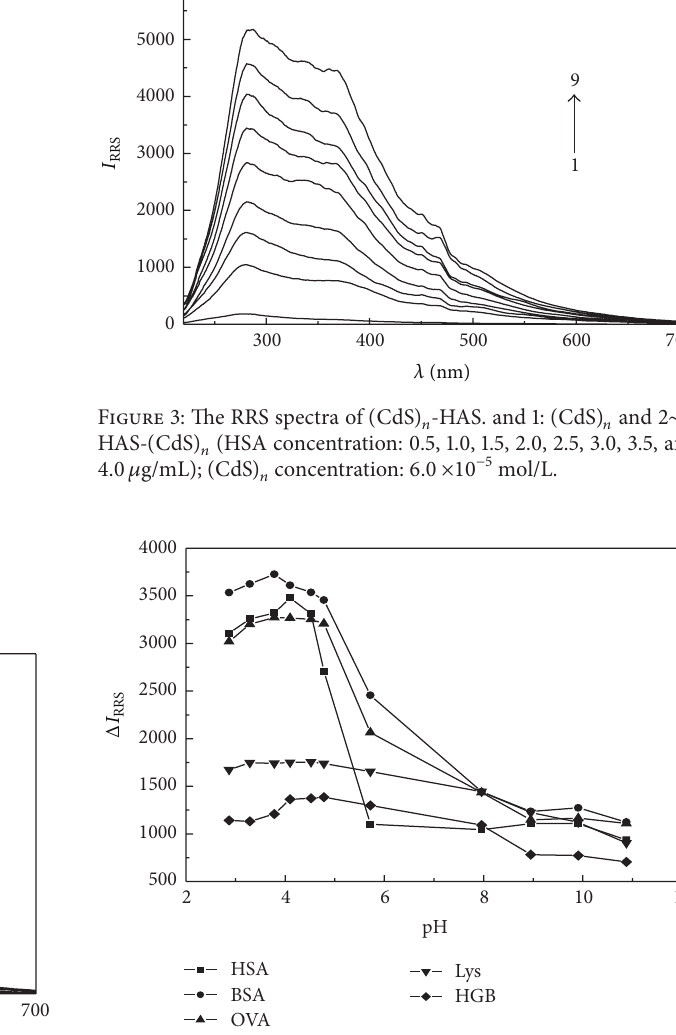
Figure 2: The RRS spectra of binding products of ( CdS ) 𝑛 with proteins. 1: ( CdS ) 𝑛 , 2: HSA, 3: BSA, 4: OVA, 5: HGB, 6: Lys, 7: ( CdS ) 𝑛 -HGB, 8: ( CdS ) 𝑛 -Lys, 9: ( CdS ) 𝑛 -OVA, 10: ( CdS ) 𝑛 -HSA, and 11: ( CdS ) 𝑛 -BSA. Proteins concentrations: 2.5 𝜇 g/mL; ( CdS ) 𝑛 concentration: 6.0 × 10 −5 mol/L.